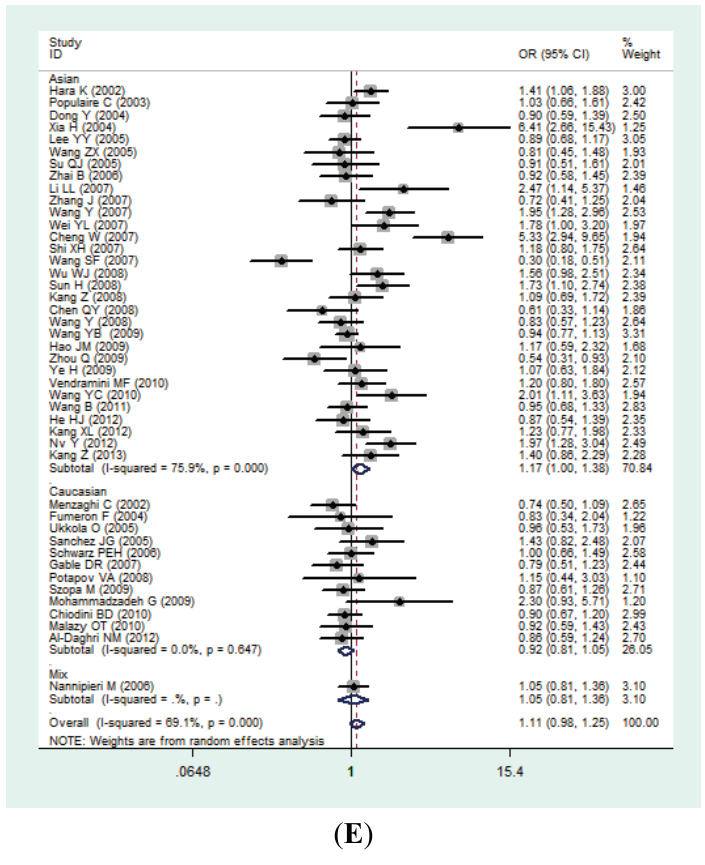
Figure 2. Forest plots for the ADIPOQ gene +45T>G polymorphism and T2DM risk in different genetic models. ( A ) Allelic model: G vs. T; ( B ) Dominant model: GG + GT vs. TT; ( C ) Recessive model: GG vs. GT + TT; ( D ) Homozygous model: GG vs. TT; and ( E ) Heterozygous model: GT vs.